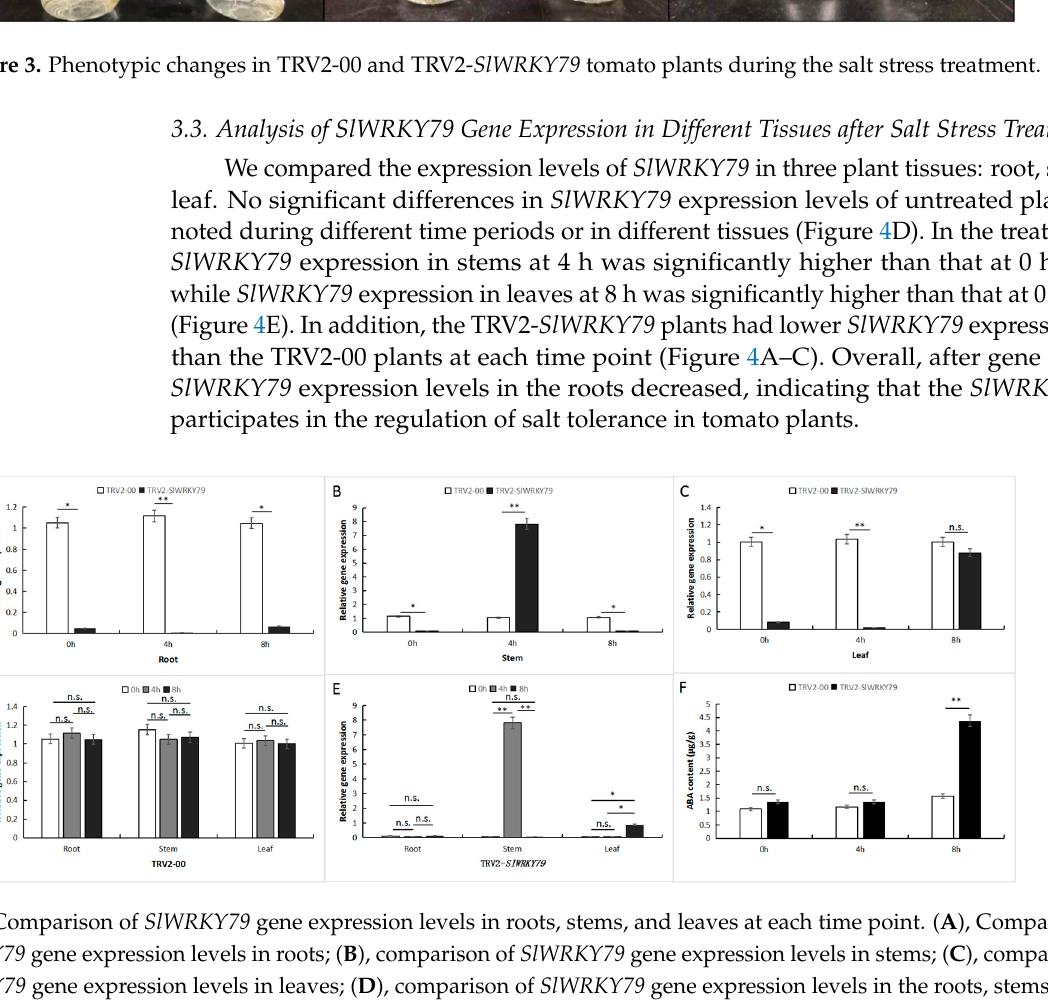
Figure 3. Phenotypic changes in TRV2-00 and TRV2- SlWRKY79 tomato plants during the salt stress treatment.